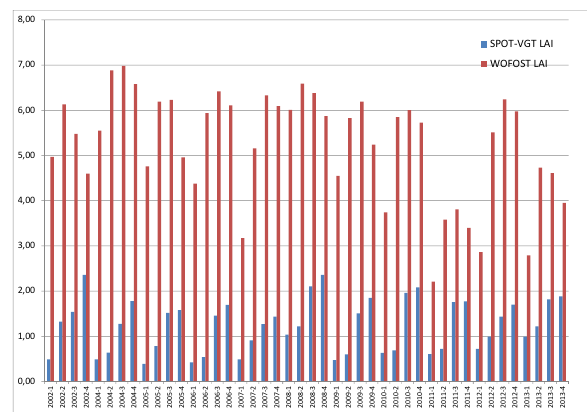
Figure. 4. LAI values derived from SPOT-VGT and WOFOST model at the field